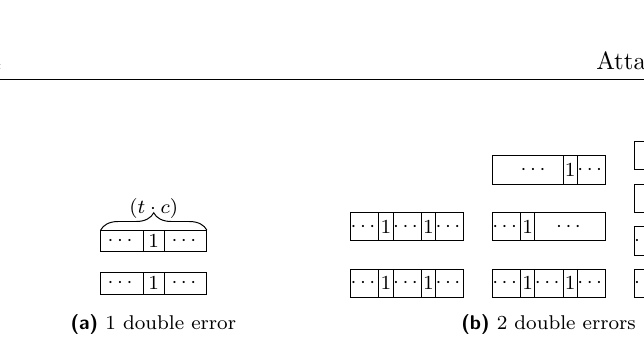
Figure 3: Illustration for the colliding